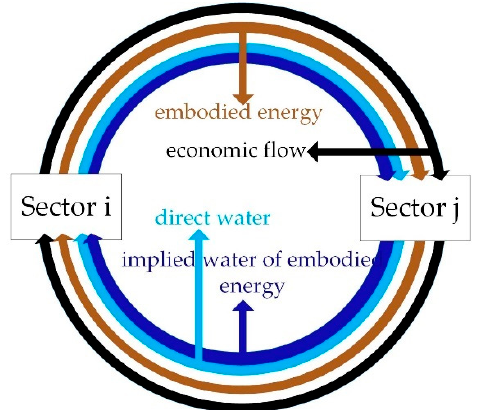
Figure 2. In the national economic system, economic, energy, and water flows exist among most of the sectors. A brief description is given in this figure for sectors i and j . The circulation of products or services between sectors i and j is called the economic flow. Water resources directly consumed by the industrial sector circulate among sectors via products or services; this is called direct water flow. Industrial development also requires the consumption of energy, which may derive from local production or external inputs, and is called embodied energy. Energy consumed in the industrial sector also requires water during the production process; these potential water resources also circulate among the various sectors by means of products or services, and are referred to as the IWEE. Combining direct water flow with the IWEE means considering the water consumption of energy based on direct water use, and exploring the water flow characteristics among the sectors.